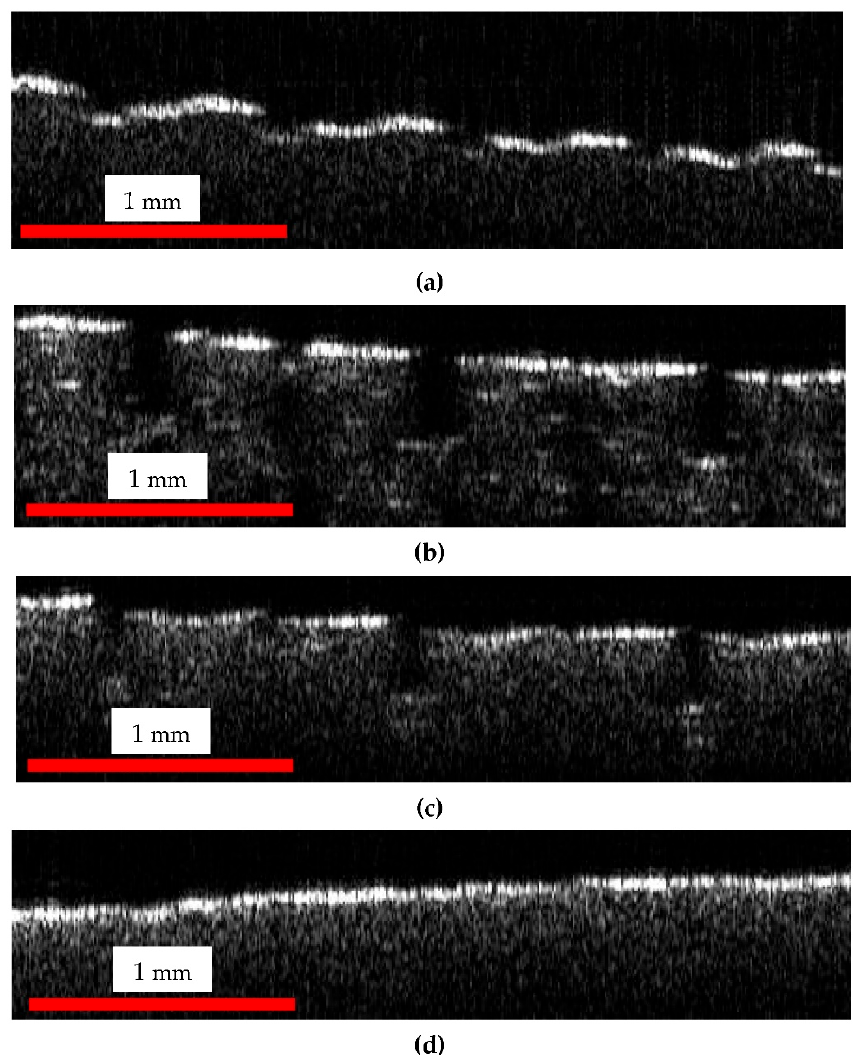
Figure 6. B-scans of sample plates from ( a ) the control group, ( b ) top, ( c ) middle, and ( d ) bottom zone of the bioreactor. The dimensions of the image are 3.5 (lateral) × 1.1 (vertical, along depth measured in air) mm 2 . B-scans are obtained parallel to the dashed line in Figure 5.